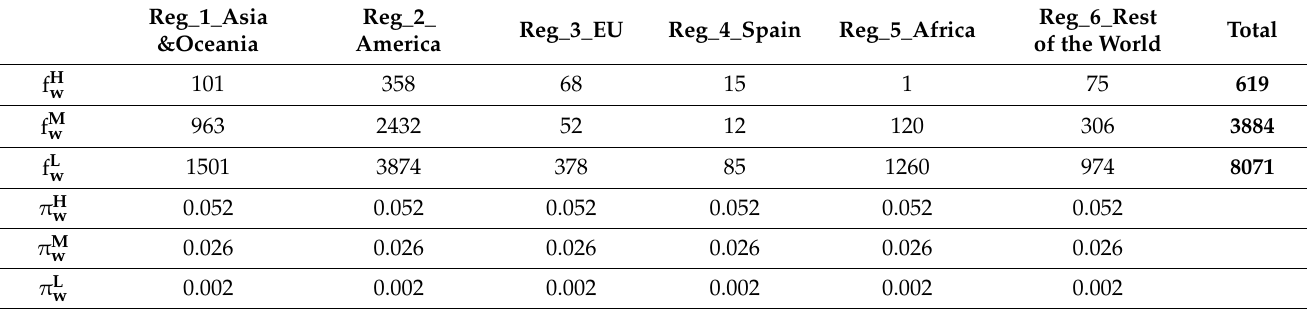
Table 3. f Q w water (W) endowment and prices of the water split of Factor 4 into 3 qualities (Q), low (L), medium (M) and high